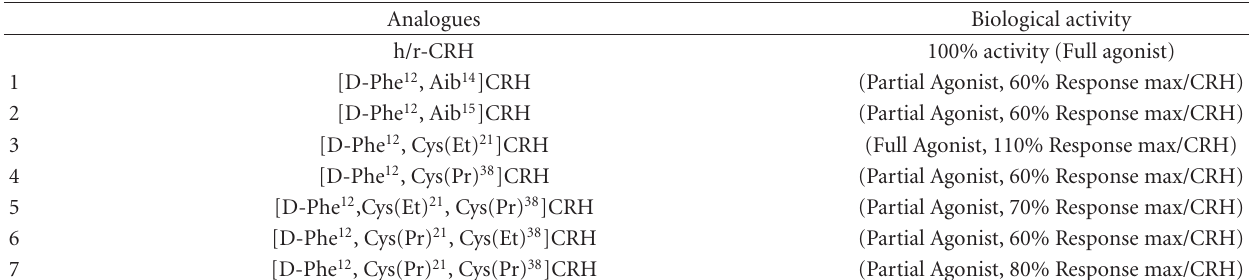
Table 4: Biological activity of h/r-CRH